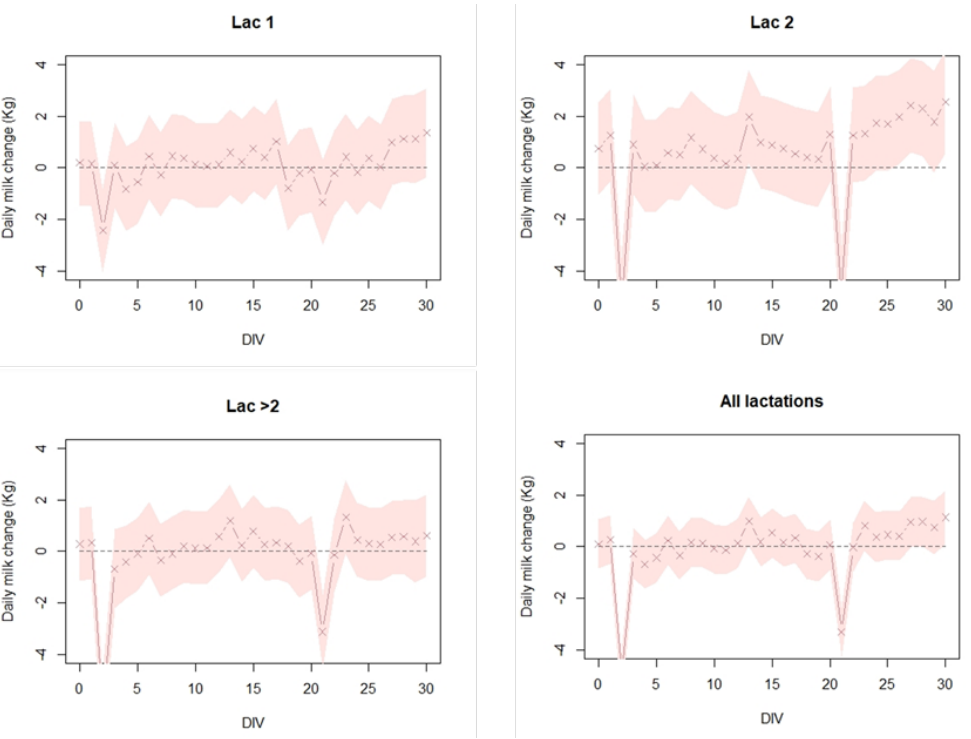
Figure 4. The estimated daily milk change (Kg) per cow in 4 dairy cattle farms in Israel, during a 30-day period after vaccination. Linear mixed effects model was fitted to the milk production gaps (MPG) for each cow with distance from vaccination day (DIV) as a fixed variable and the farm as a random variable. This was performed separately for lactation group 1 (Lac 1-naive), lactation group 2 (Lac 2-mixed: naïve and vaccinated), lactation group > 2 (Lac > 2-vaccinated), and all lactations groups combined (All lactations). For specific details on the model, see text.